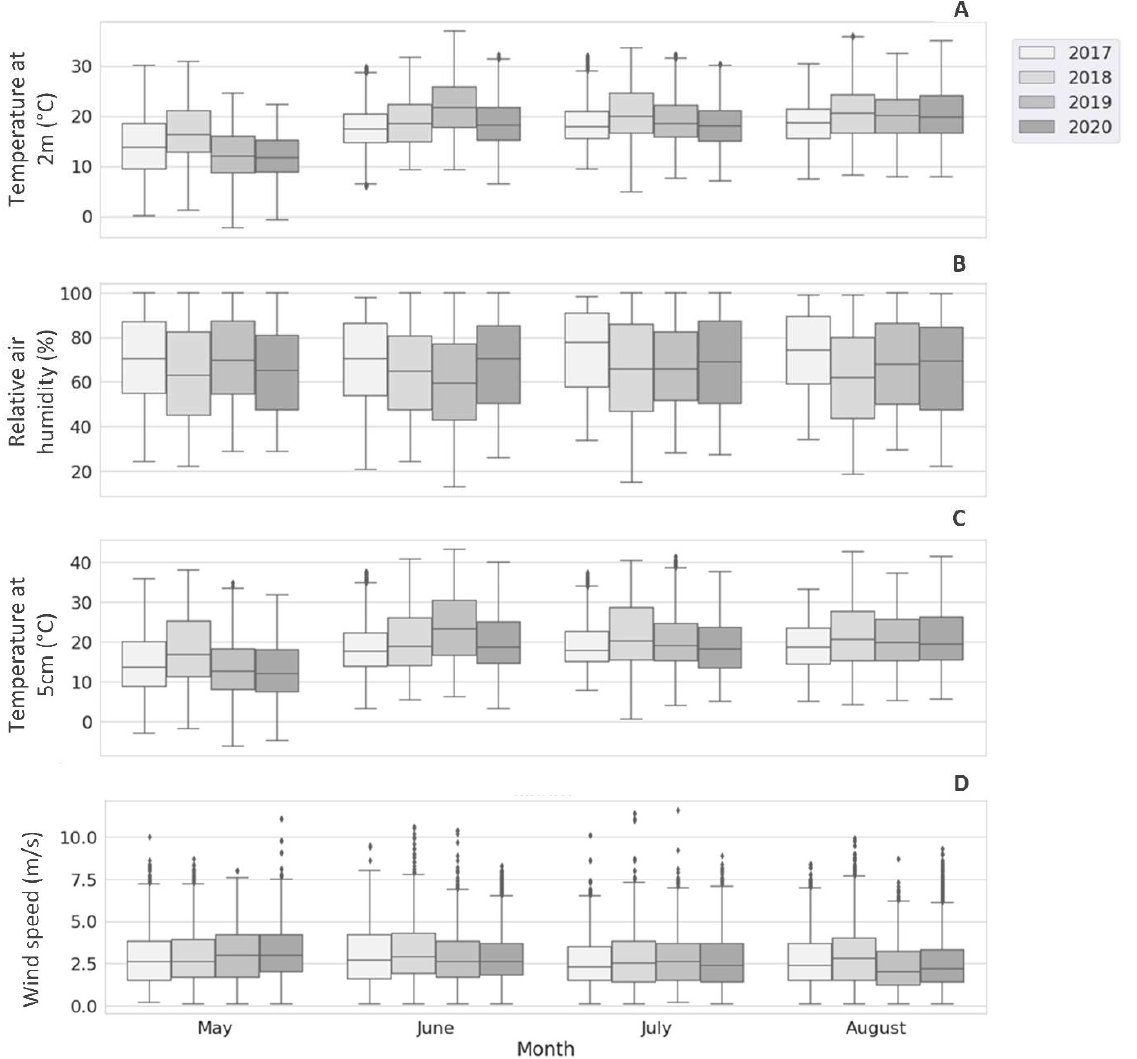
Figure 1. Hourly air temperature at 2 m ( A ), relative air humidity at 2 m ( B ), soil surface temperature at 5 cm ( C ), and wind speed ( D ) for the years 2017, 2018, 2019, and 2020.